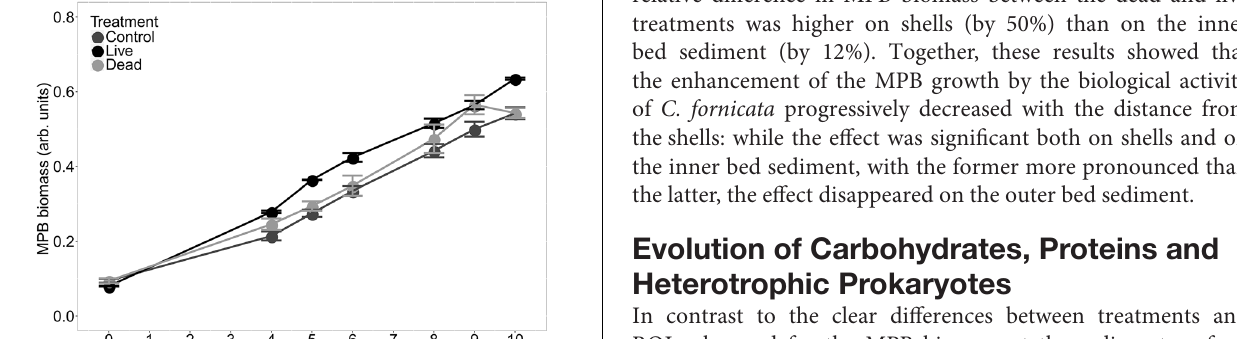
and 3rd end-member spectra identified pseudofeces and MPB, respectively. Images of the magnitude of the 2nd end-member showed that pseudofeces were distributed on one side of live stacks (e.g., white arrow 1 (cid:13) in Figure 4D ), predominantly in the direction of ex-current flow associated with filtration of C. fornicata individuals (which all are oriented in the same way), and that they were clearly absent around the dead Crepidula stacks ( Figure 4C ). In contrast, MPB biomass was distributed heterogeneously on and around shells, with the highest density close to live shells (e.g., white arrow 2 (cid:13) in Figure 4F , contrast with Figure 4E ).